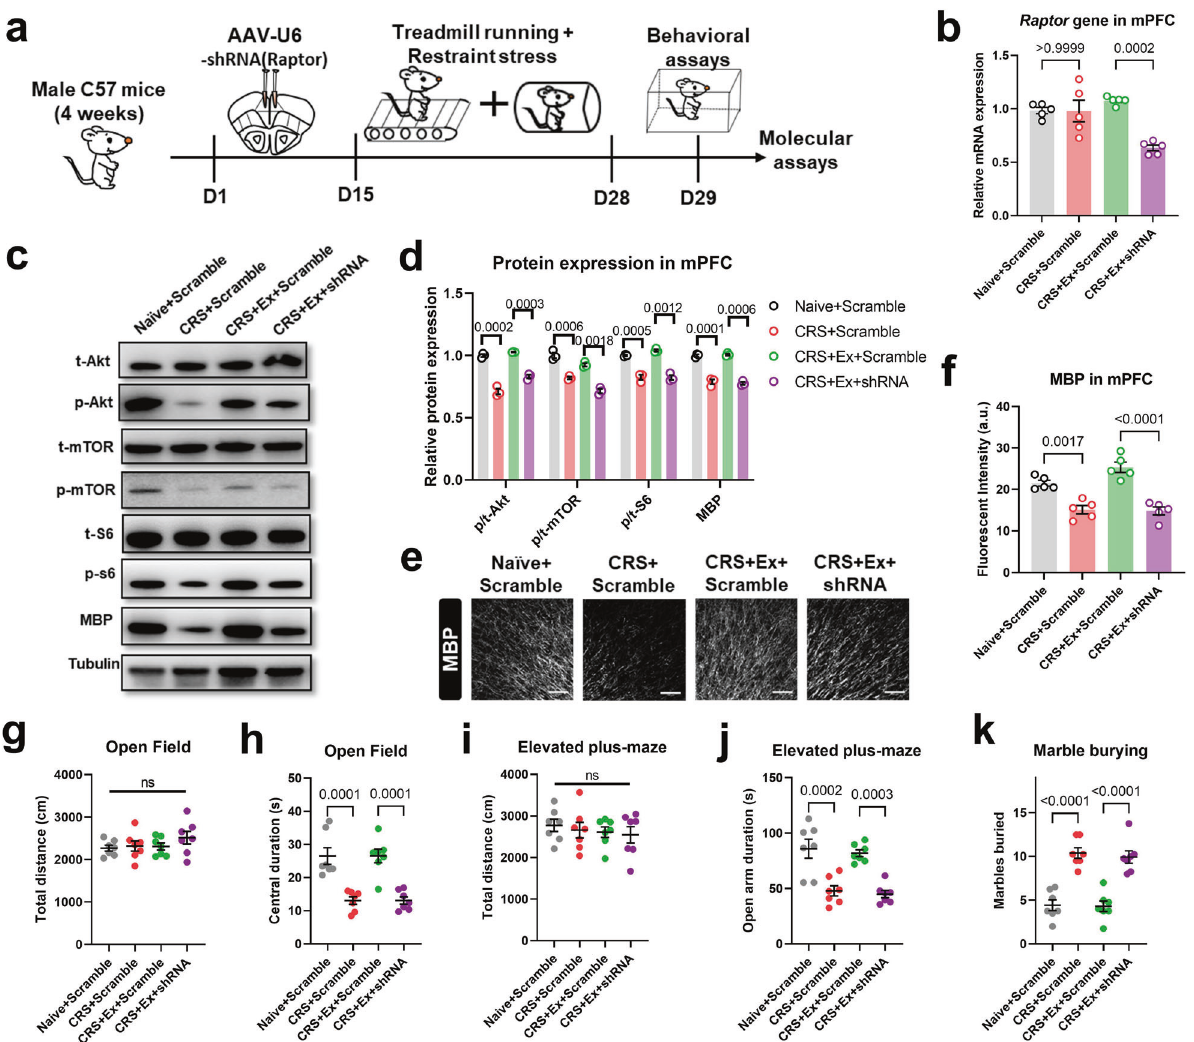
F (3,16) = 12.48, P = 0.0002. N = 5 mice per group. Tukey ’ s post-hoc test was used for comparisons between the two groups. c Representative Western blotting bands for mTOR proteins and MBP expression in PFC extracts. d Quanti fi cation of relative protein expression showed